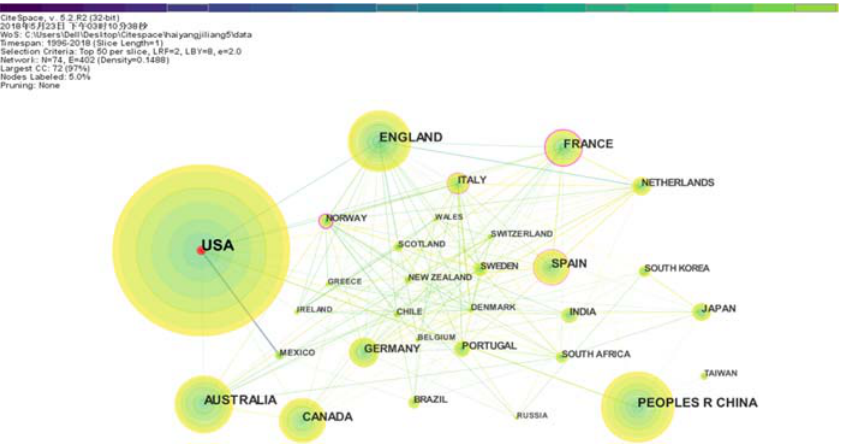
Figure 10. Network of cooperation between the 29 countries with the largest number of marine